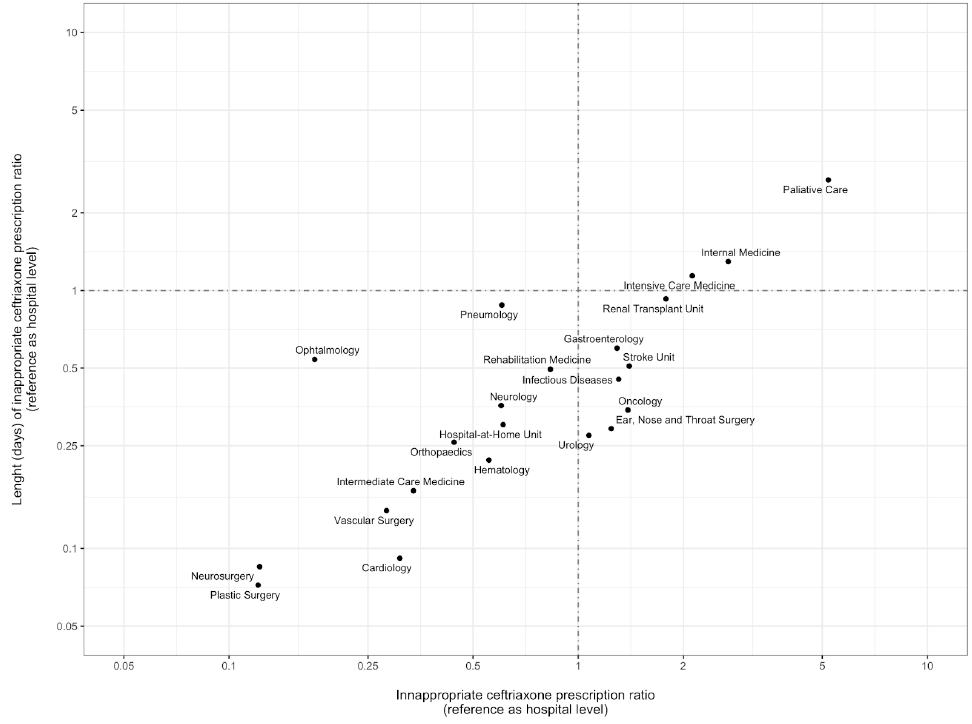
Figure 2. Evaluation of inappropriate empirical prescription of ceftriaxone, per department. Comparison between departments was performed using a ratio between the observed number of days of inappropriate ceftriaxone prescriptions and the expected number of days of inappropriate ceftri- axone prescriptions (with hospital level as reference). Dots represent the different hospital depart- ments evaluated. The vertical and horizontal dot–dash lines represent the general hospital ratio (where the values observed correspond to the values expected for the number of inappropriate pre- scriptions and duration of inappropriate prescriptions). The axis values are represented in a loga- rithmic scale. 3. Discussion This study evaluated 465 patients with empirical ceftriaxone prescription over a two- month period. We studied ceftriaxone prescriptions from all hospital departments (ED, surgical, medical, and ICU) independently of their inherent variability, providing a more realistic picture of ceftriaxone prescription in routine clinical practice. In a high proportion of patients (46.5%), this prescription was inappropriate, corre- sponding to 1012 days of inappropriate ceftriaxone use. These results are similar to those found in studies focused on the quality of antibiotic prescription, although there is high heterogeneity regarding prescription setting and methodology for quality assessments [20–22]. In approximately two-thirds of inappropriate prescriptions, ceftriaxone was con- sidered to have an excessive spectrum of antimicrobial activity. Lower respiratory infections were the most frequent syndrome with inappropriate ceftriaxone prescription across all major hospital departments. Ceftriaxone has not been associated with better outcomes in community-acquired pneumonia compared to